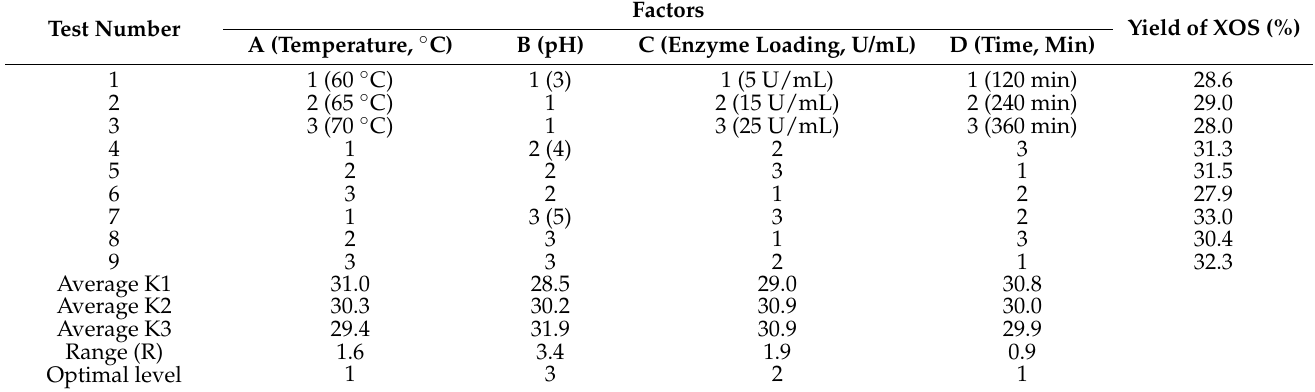
Table 3. The L9 orthogonal array applied for XOS production.